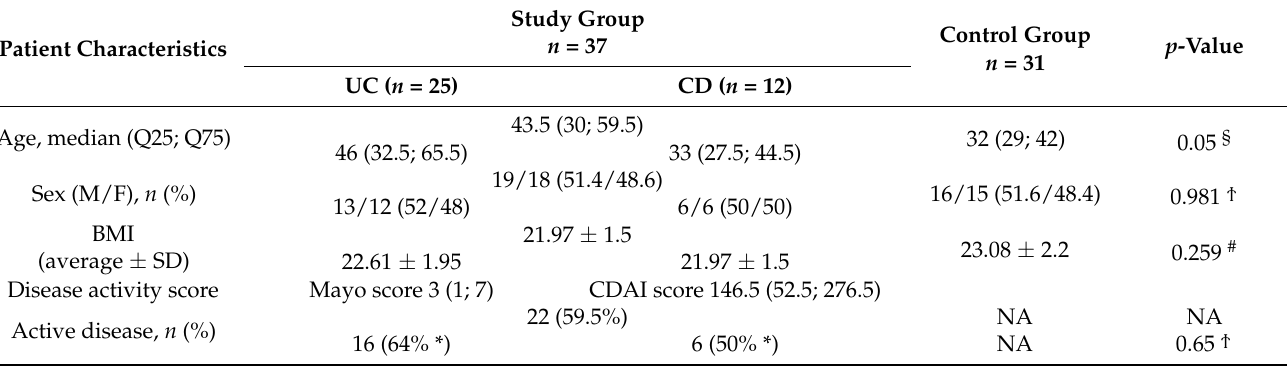
Table 1. Patient characteristics.